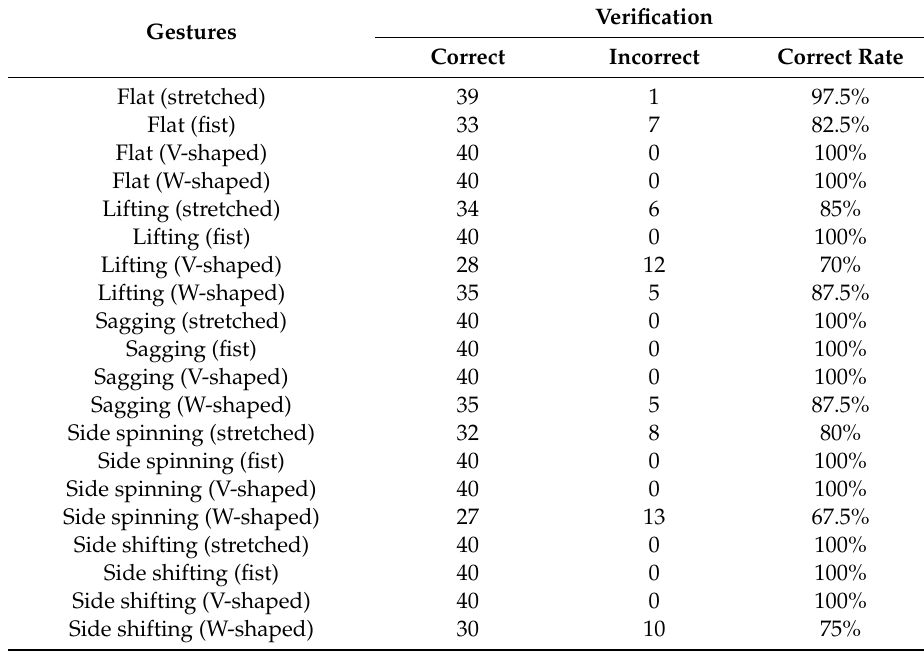
Table 3. Static gesture